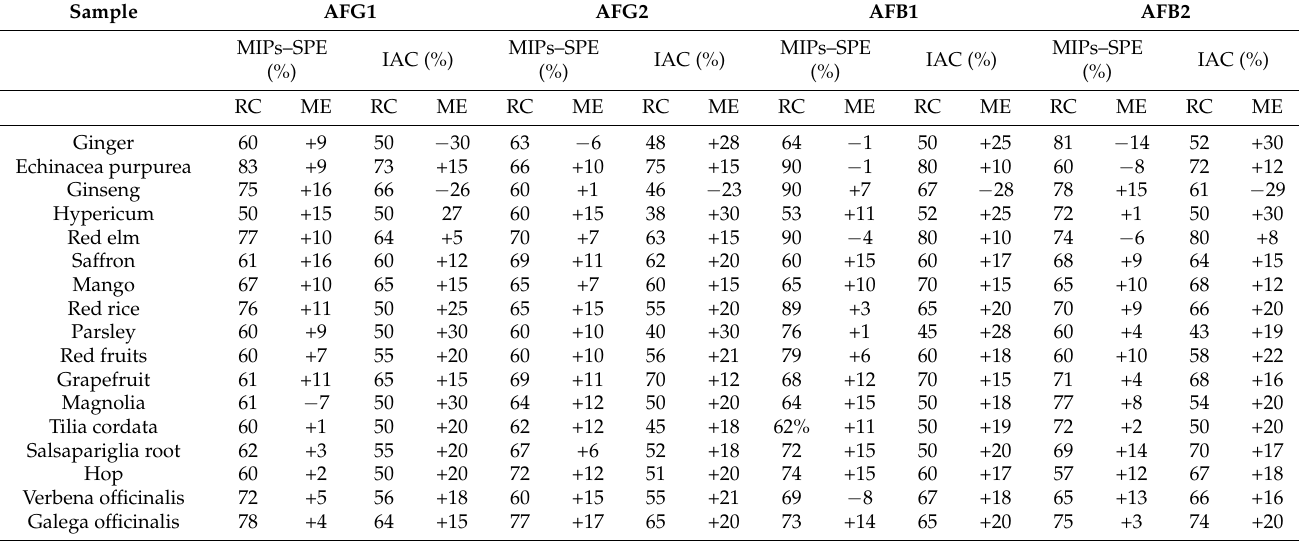
Table 2. Data obtained analyzing food samples using the MIPs-based and IAC-based